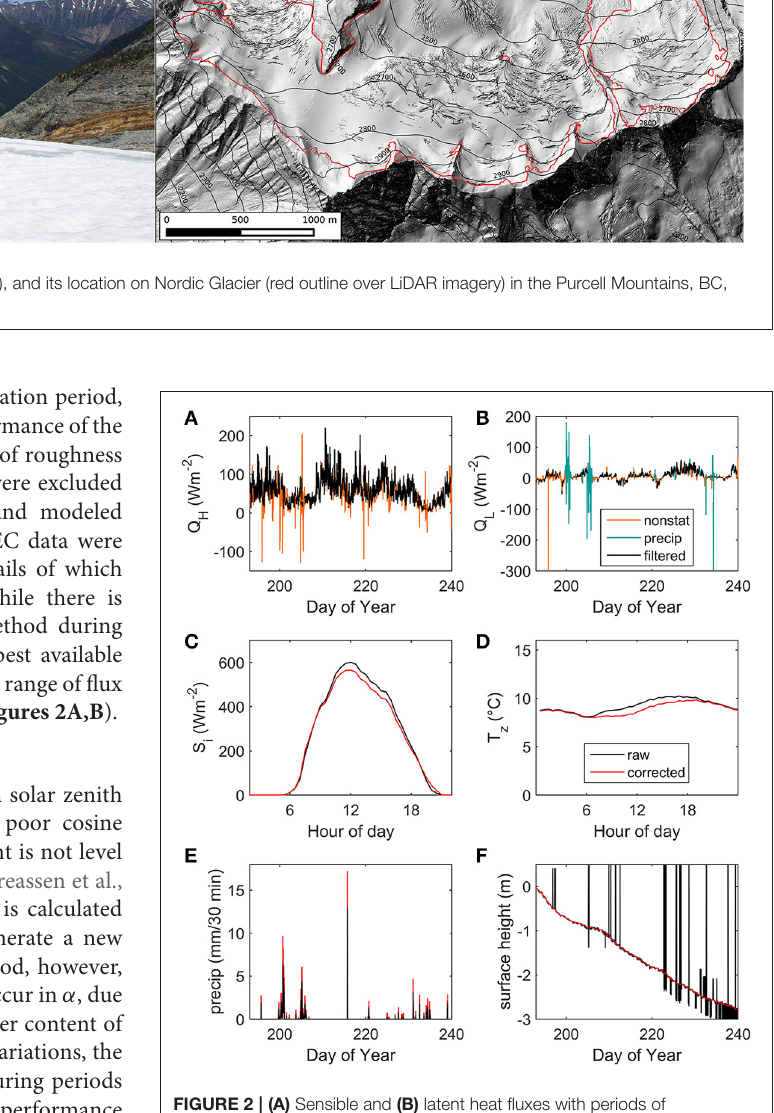
FIGURE 2 | (A) Sensible and (B) latent heat fluxes with periods of non-stationary turbulence (orange) identified through the methods of Foken (2008), and periods of precipitation and the subsequent 90 min (teal), when the gas analyser windows may have been partially obscured. Also shown are the raw and corrected observation data for (C) the mean daily cycle (over 47 days) of incoming shortwave radiation, (D) the mean daily trend of near-surface air temperature, (E) 30 min precipitation, and (F) 30 min surface